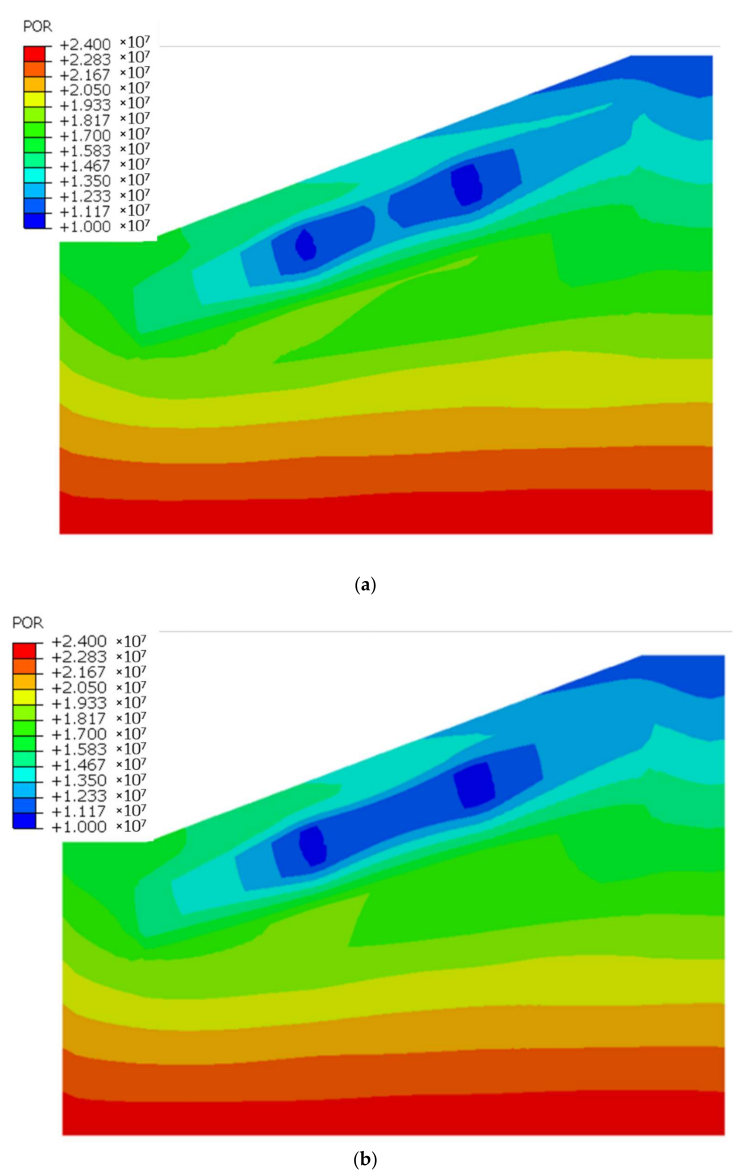
Figure 5. Distribution of pore pressure in the formation after different durations. ( a ) Pore pressure distribution after 220 days (decomposition range: 50 m). ( b ) Pore pressure distribution after 430 days (decomposition range: 150